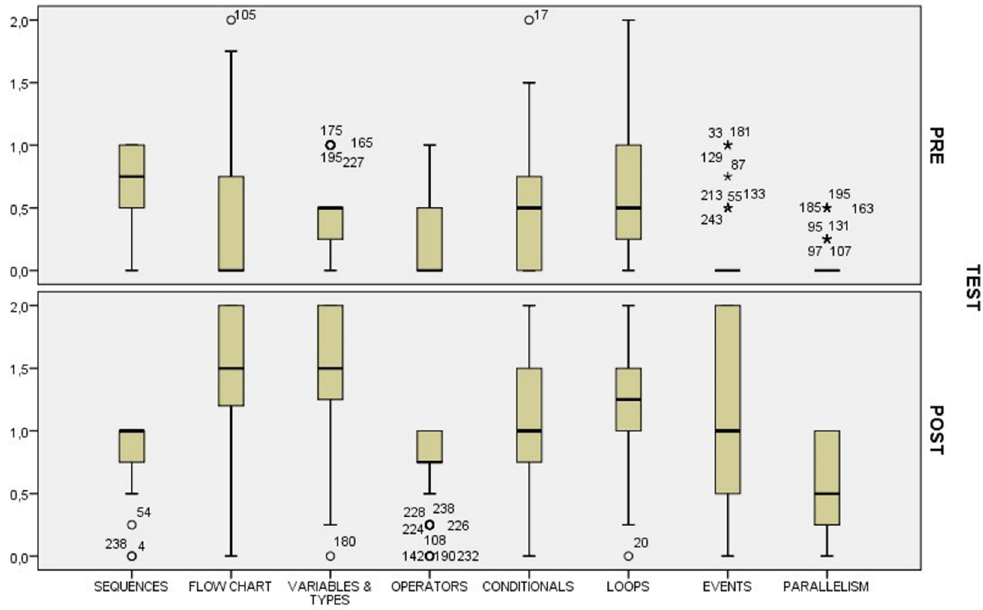
Figure 5. Boxplots of programming concepts from pre- and post-tests for all students. Notice that * and ⚬ are outliers in the distribution. * and ◦ are outliers in the